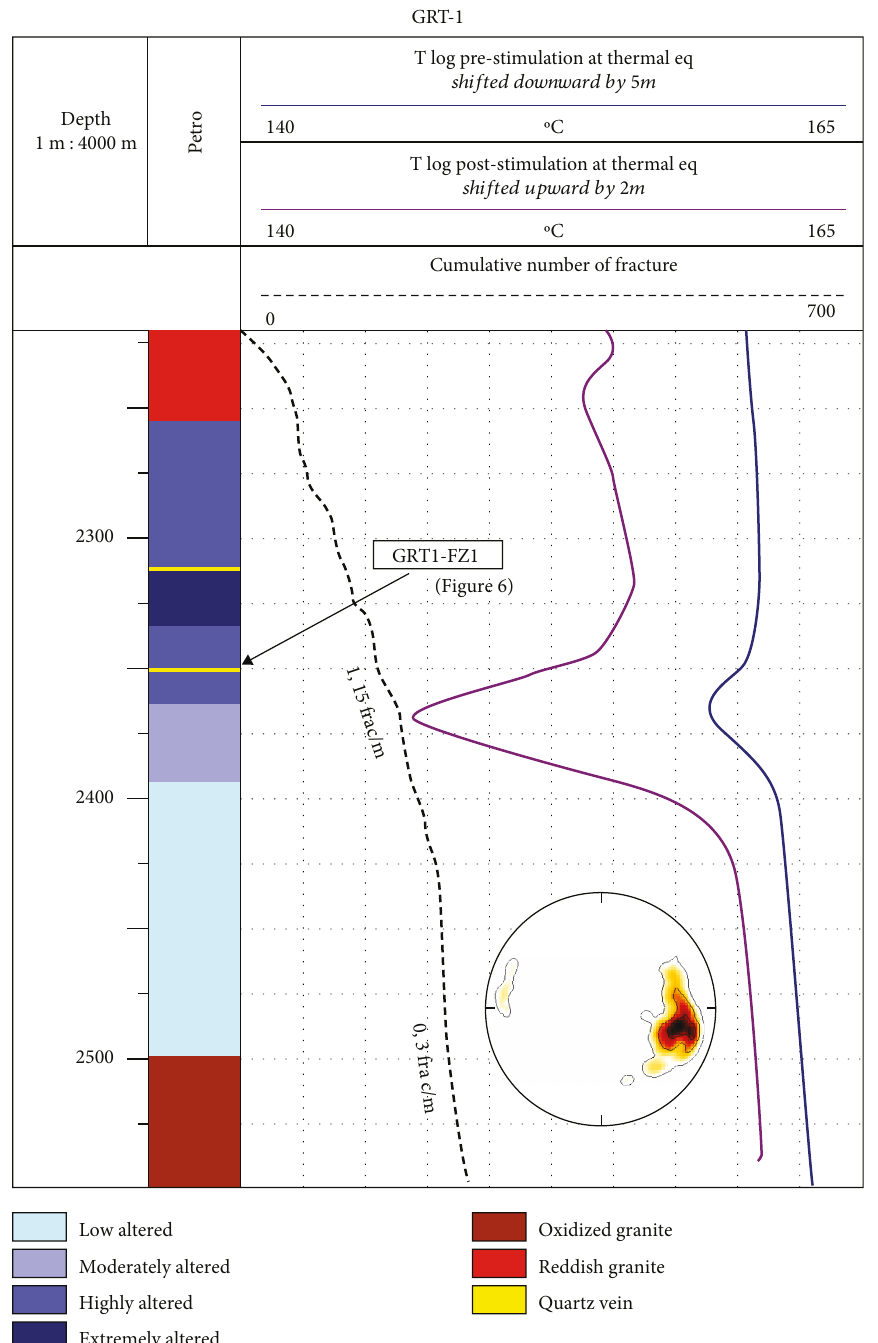
Figure 3: T logs from the granitic basement at thermal equilibrium in GRT-1 prestimulation (Apr 2013, four months after hydraulic tests) and poststimulation (Dec 2013, fi ve months after hydraulic stimulation). T anomalies are associated with the permeable FZs observed in the image logs. The structural data of these FZs are presented in Table 1. Depth is expressed in Measured Depth (MD). T logs and fl ow logs were shifted manually to fi t the anomalies with the fracture zones. Petrographic results are from Vidal et al. [44] and Glaas et al. [41]. Schmidt diagrams (lower hemisphere) and the cumulative number of fractures in the granitic basement are from Vidal et al.